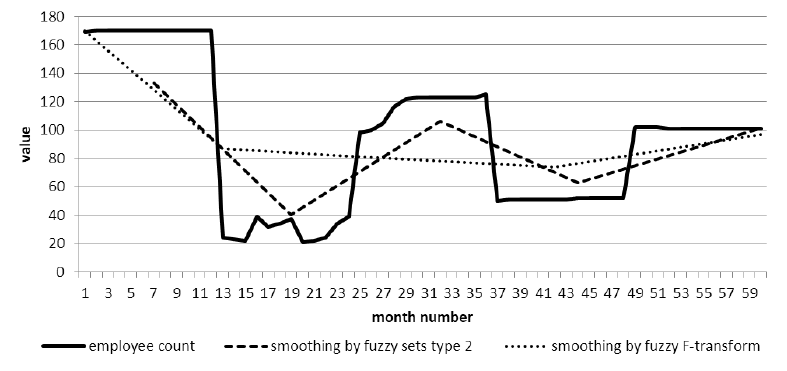
Figure 12. Employees number time series